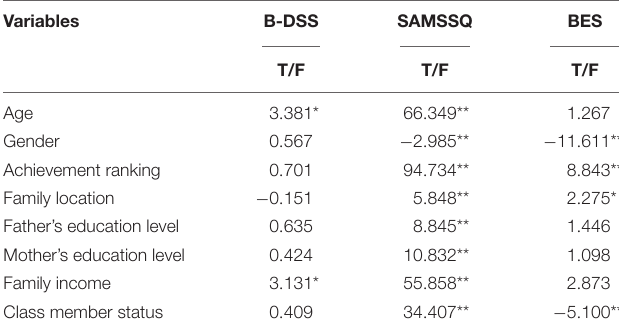
TABLE 2 | Variance analysis of the demographic variables and the scores for the three kinds of abilities. Variables